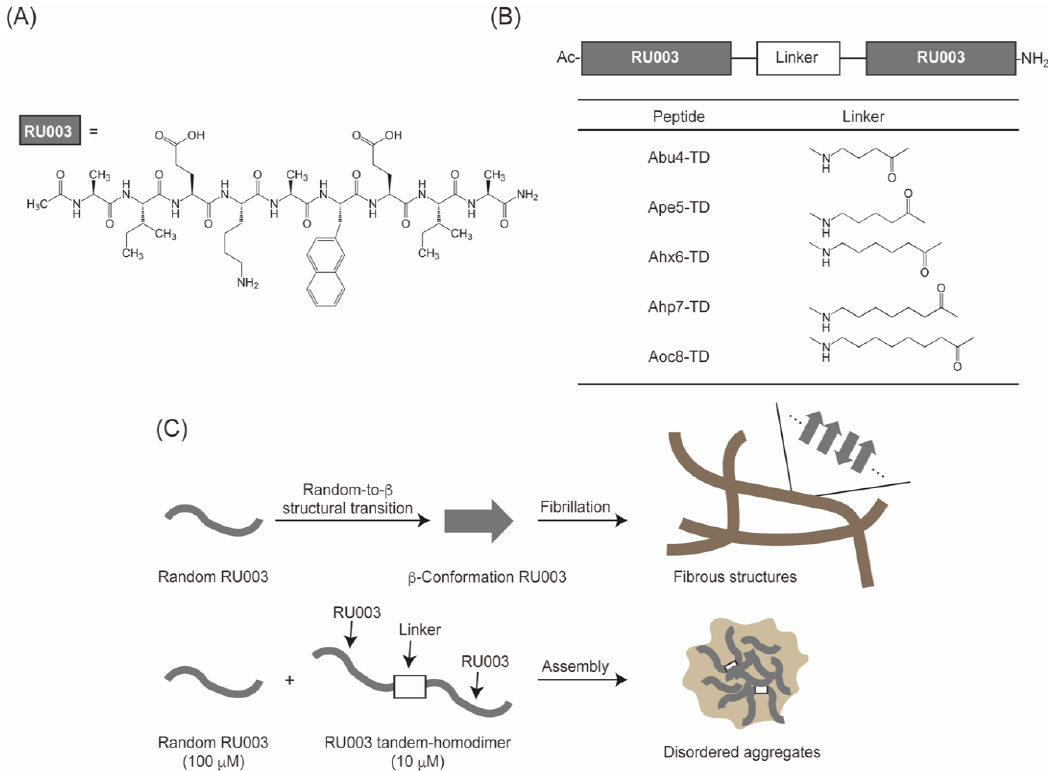
Figure 1. Amino acid sequences of the β -sheet-forming peptides. ( A ) The original nonapeptide RU003, ( B ) RU003 tandem-homodimers connected by an alkanoic amino acid with different chain lengths, and ( C ) inhibition of the random-to- β structural transition and subsequent fibrillation of RU003 by the tandem-homodimers.